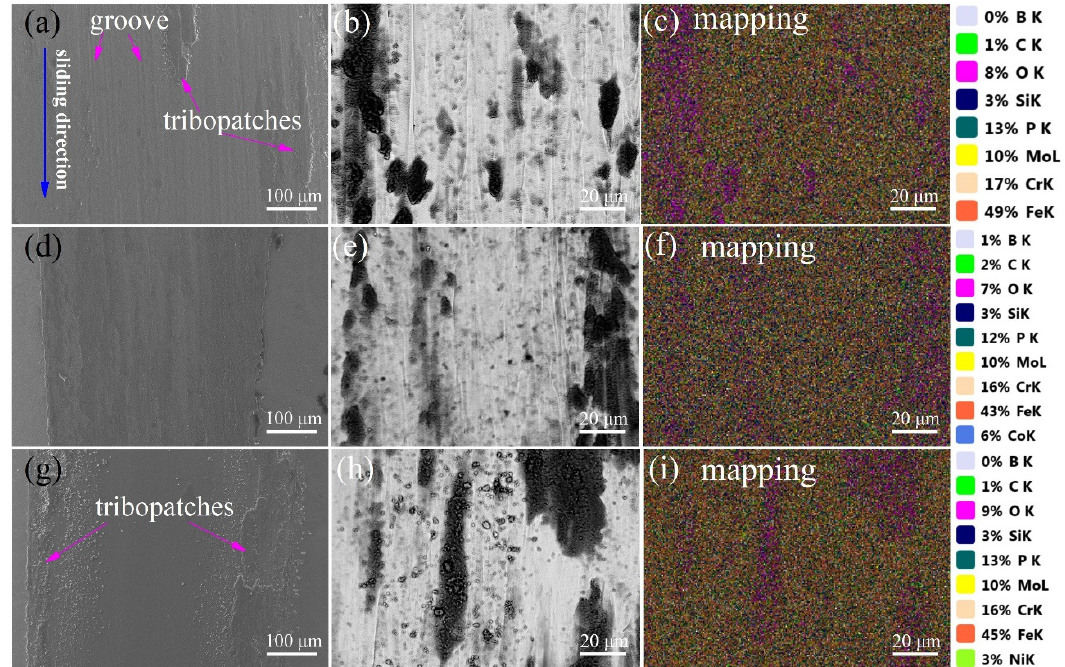
Figure 6. SEM images of wear surface morphology and EDS mapping of the Fe 59 ( a – c ), Fe 54 Co 5 ( d – f ), and Fe 54 Ni 5 ( g – i ) glassy alloy rod